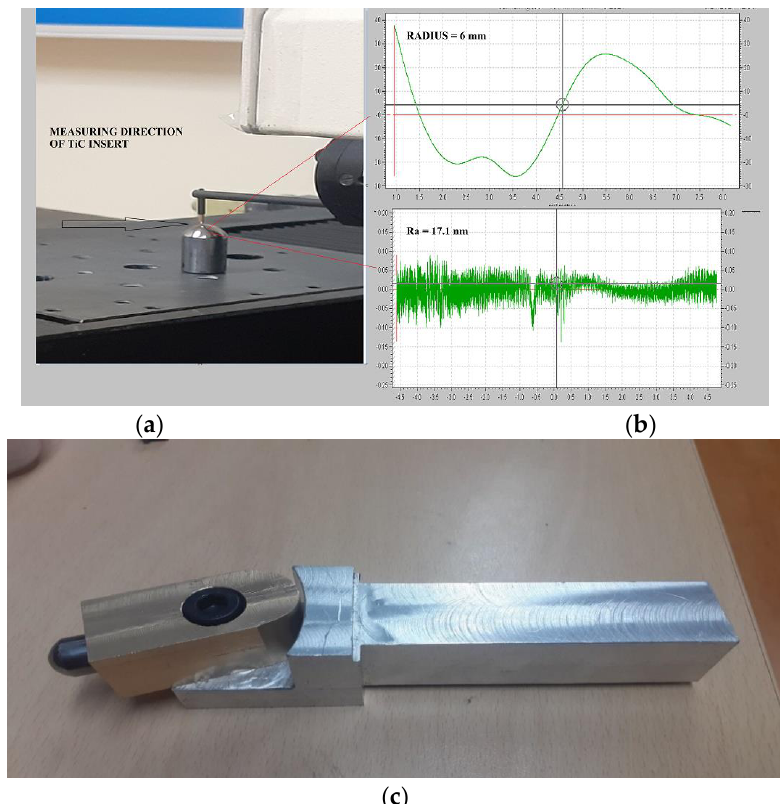
Figure 3. ( a ) Surface roughness measurement, ( b ) radius profile of insert, ( c ) actual tool insert.